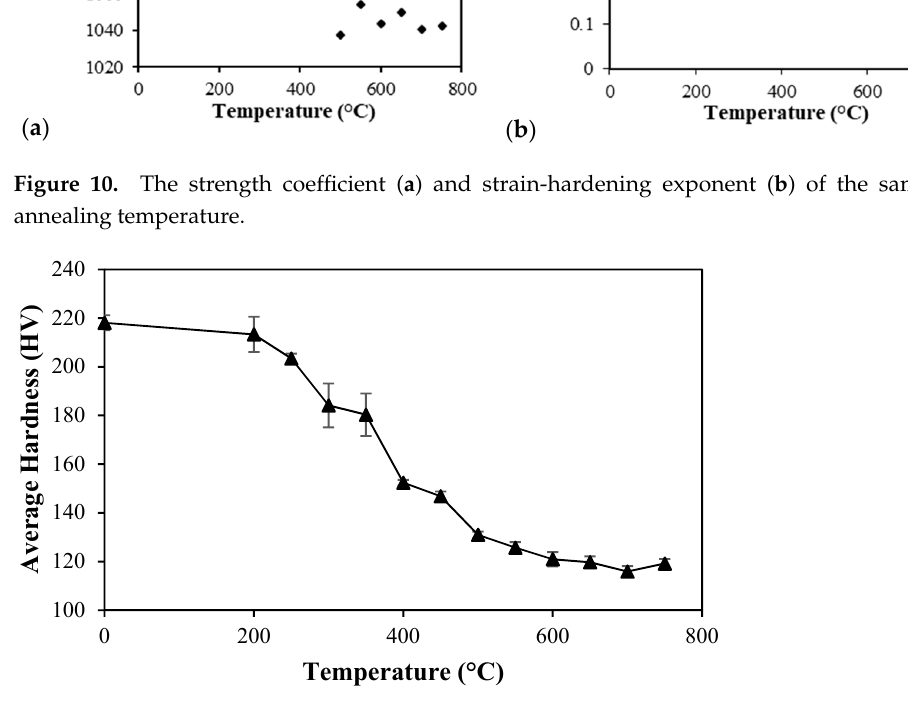
Figure 11. Effect of temperature during heat treatment on the Vickers hardness of manganese bronze.